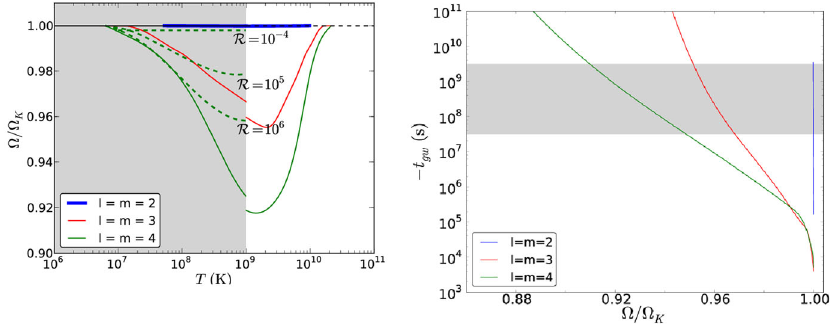
Fig. 16 Left: The f -mode instability window neutron star rotation angular frequency vs temperature. Here Ω K (cid:13) 6868rad / s is the angular frequency at the mass-shedding limit for a n = 0 . 73, and mass M = 1 . 48 M (cid:3) model with radius R = 10 . 47km (in the TOV limit). The shaded area shows the region of superfluidity, and the dashed curves represent different values for the mutual friction drag parameter R (shown only for the m = 4 mode). Right: The f -mode instability growth time as a function of Ω for the same model as in the left panel. The shaded area show the range of cooling timescales from an initial temperature T = 5 × 10 10 K to a final T = 5 − 9 × 10 8 K. (Image reproduced with permission from Gaertig et al. 2011, copyright by